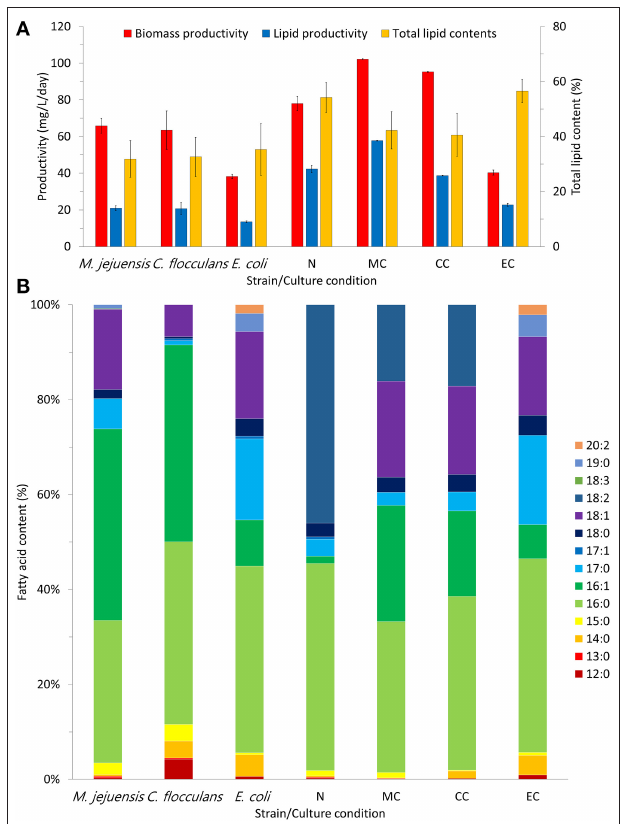
FIGURE 4 | Productivity and fatty acid composition in each culture condition. The productivity of biomass and lipid content in each culture condition was measured (A) . Through fatty acid composition analysis, we confirmed the quality of lipids that were produced in each condition (B) . MC, M. jejuensis and C. sorokiniana ; CC, C. flocculans and C. sorokiniana ; EC, E. coli and C. sorokiniana ; N, C. sorokiniana only, control group. We herein expressed the fatty acids contents, which we defined as